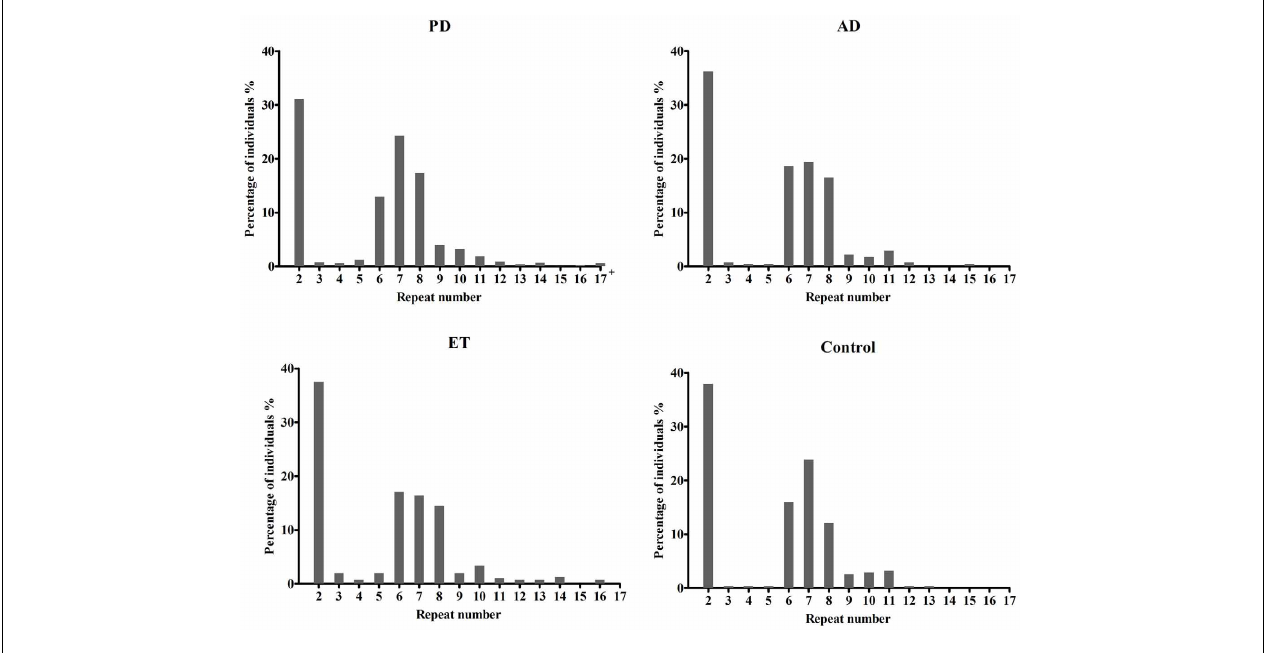
FIGURE 1 | Distributions of repeat number in C9orf72 in Alzheimer’s disease, Parkinson disease, essential tremor, and control individuals. There was no significant difference in the distributions of repeat length between AD ( p = 0 . 67), ET ( p = 0 . 13)